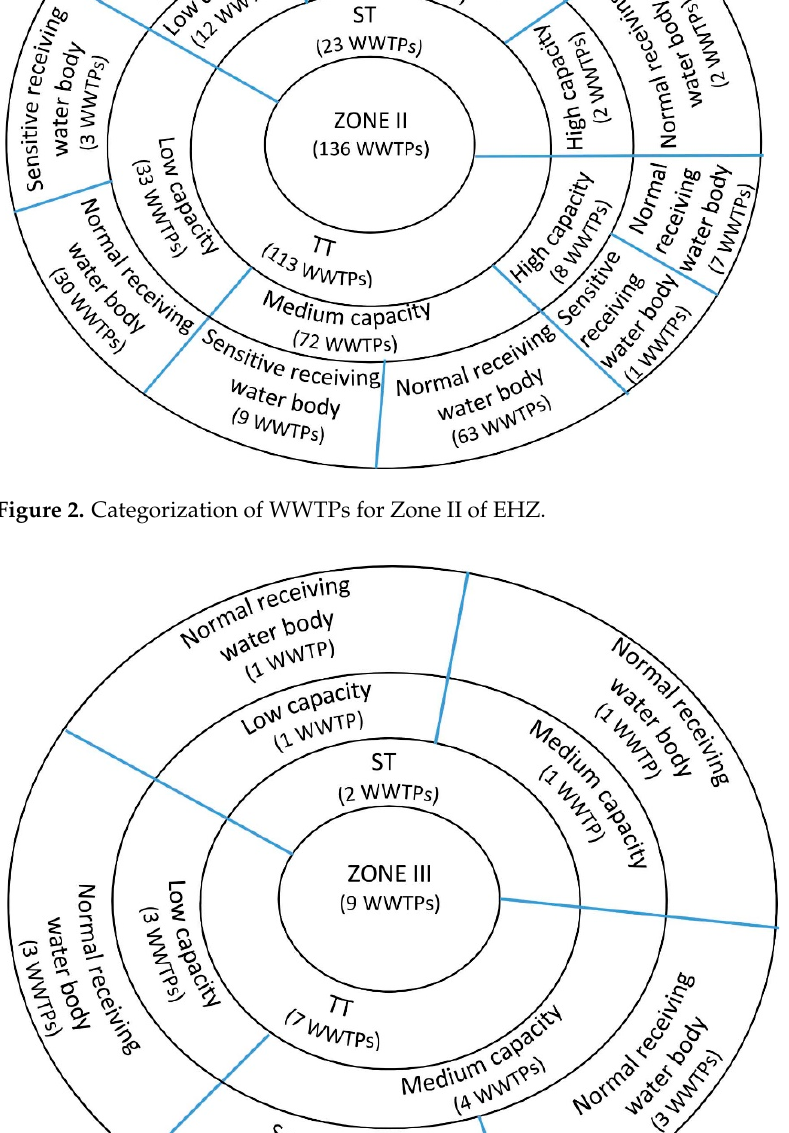
Figure 3. Categorization of WWTPs for Zone III of EHZ.